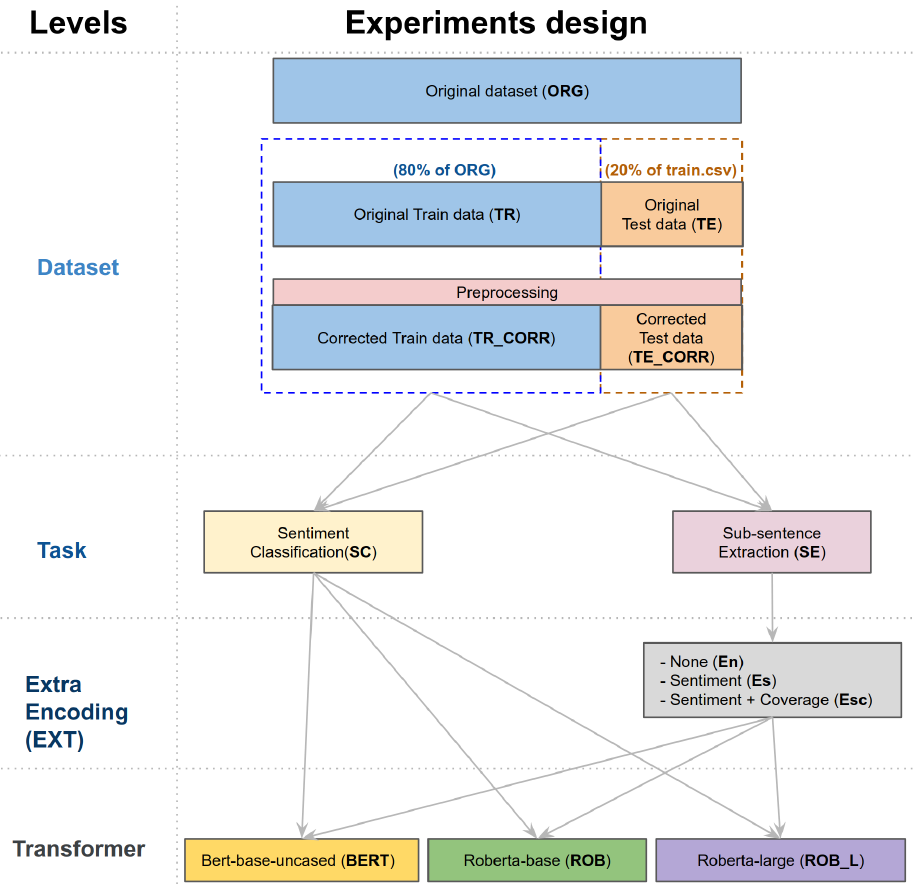
Figure 5. Experiment design. This diagram shows the experiment design scheme proposed in this manuscript. There are total 24 experiments named by the following